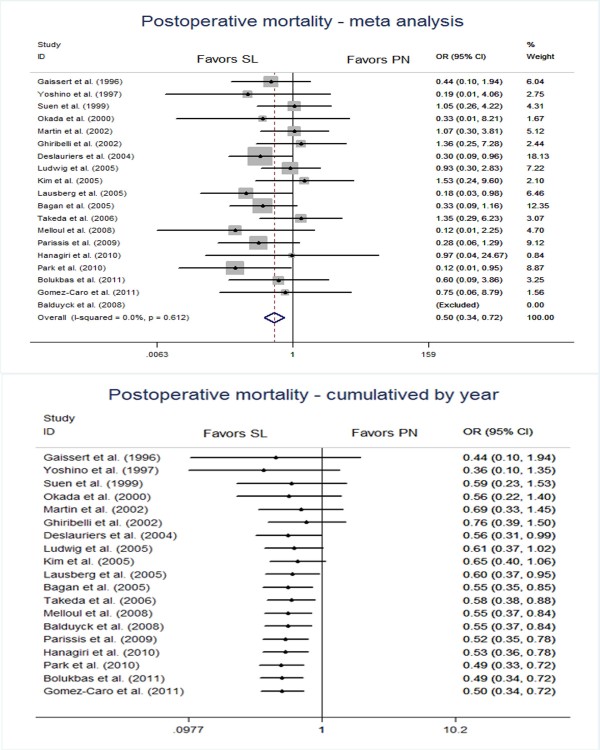
Conventional and cumulative meta-analysis of selected studies comparing postoperative mortality between the sleeve lobectomy group and the pneumonectomy group.